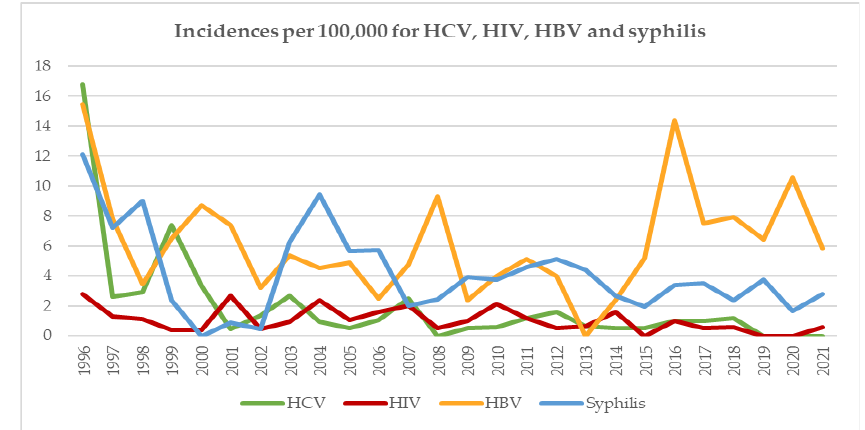
Figure 3. Incidences per 100,000 RD of HCV, HIV, HBV and syphilis from 1996-2021.